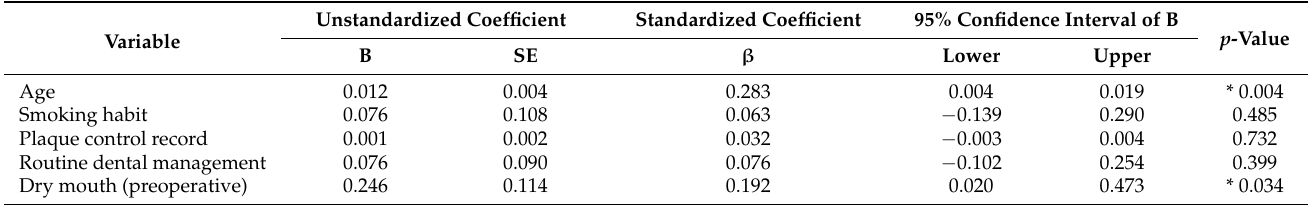
Table 3. Factors related to number of bacteria in saliva before surgery (multivariate analysis).